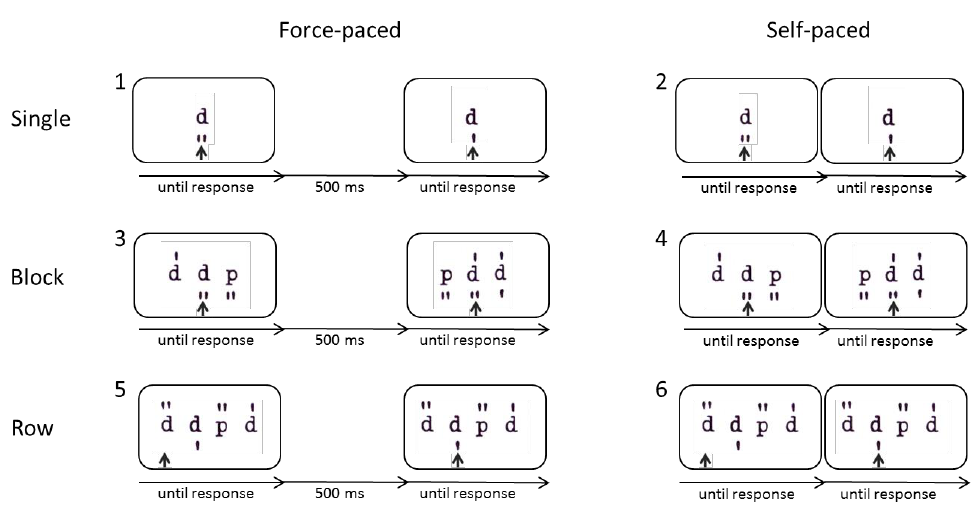
Figure 1. Illustration of the six different conditions of the modified d2, varying stimulus arrangement (single, block, row) and pace (force-paced [with response-stimulus interval] versus self-paced [without response-stimulus interval]). For all of these conditions, the task was to decide whether the relevant stimulus, as indicated by an arrow, was a d2 or not and to press the corresponding key.